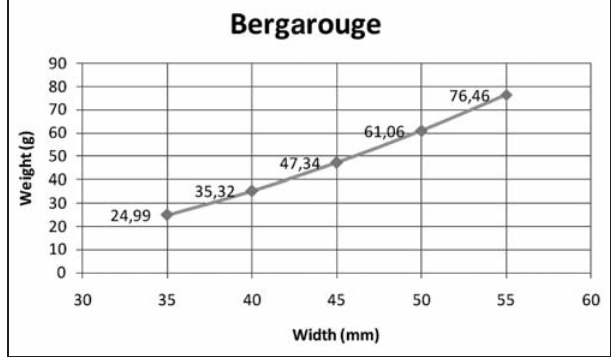
Fig. 25: Weight values calculated from the width-weight formula